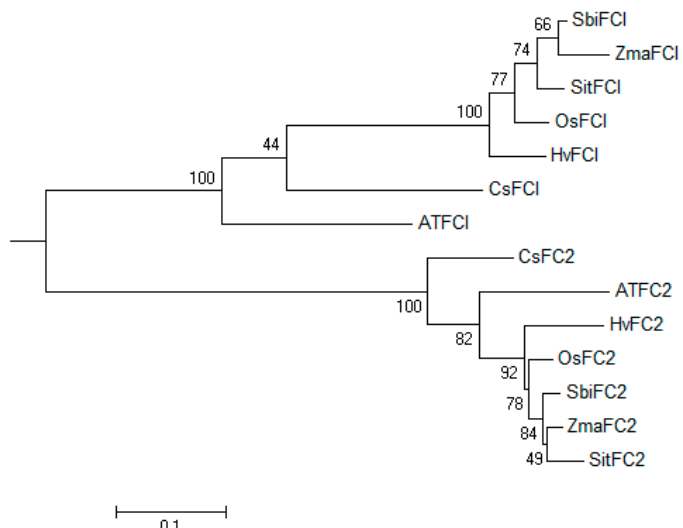
Figure 2. Phylogenetic relationship of HvFC1 and HvFC2 with other FC from grass and dicot species. At, Arabidopsis ( Arabidopsis thaliana ); Cs, cucumber ( Cucumis sativa ); Hv , barley ( Hordeum vulgare ); Os, rice ( Oryza sativa ); Sit, foxtail millet ( Setaria italica ); Sbi, Sorghum ( Sorghum bicolor ); Zma, Maize ( Zea maize ). The maximum likelihood tree was constructed, and reliability of the tree was estimated using bootstrap method.